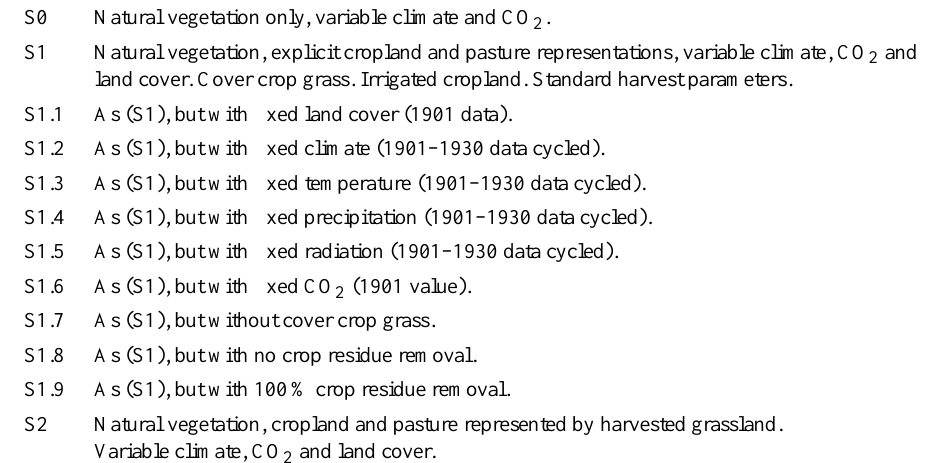
Natural vegetation, cropland and pasture represented by harvested grassland. Variable climate, CO 2 and land